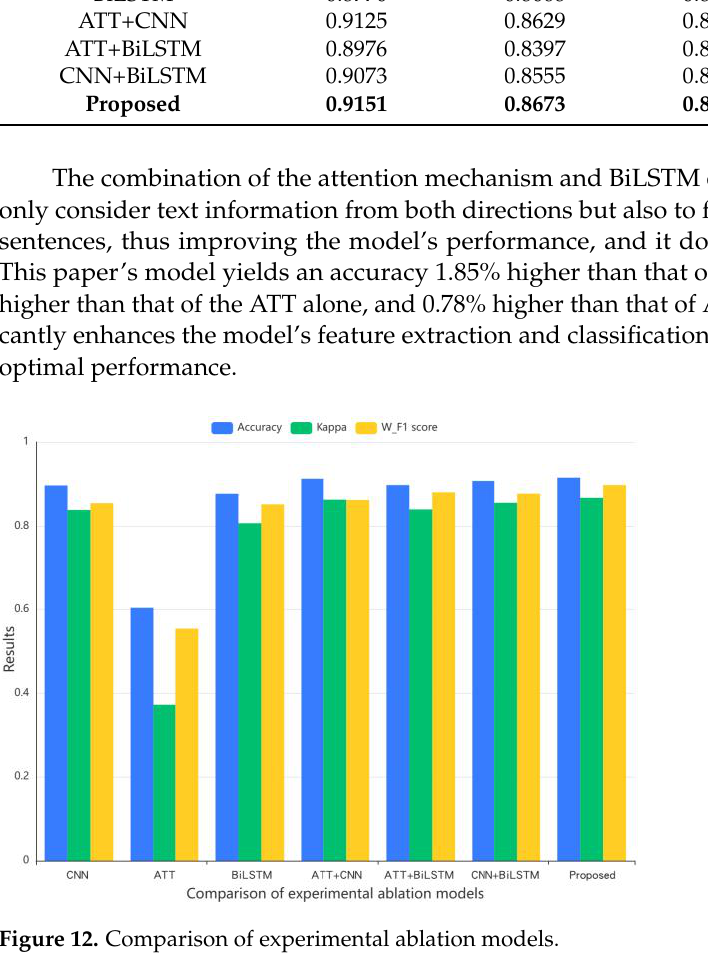
Table 10. Comparison of experimental ablation models.